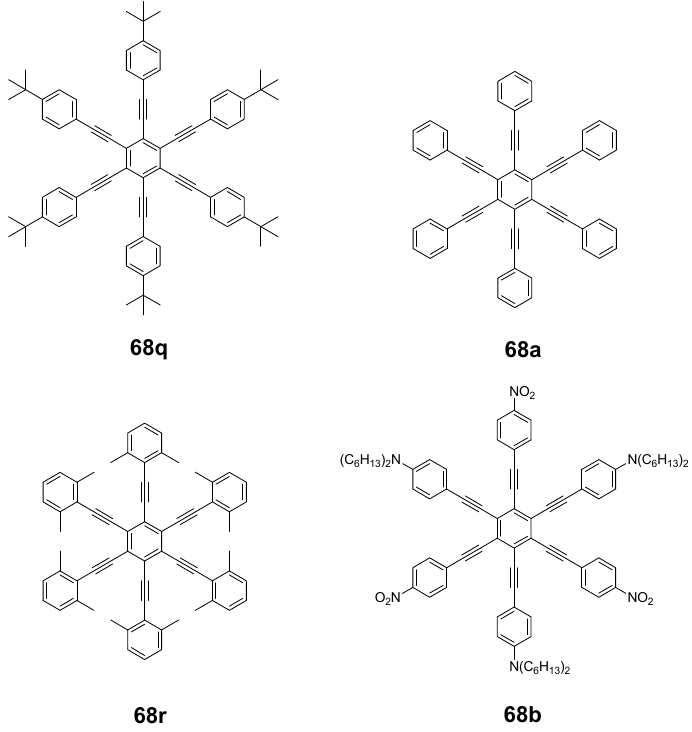
Figure 27. Hexa(phenylethynyl)benzene stars for NLO or two-photon absorption